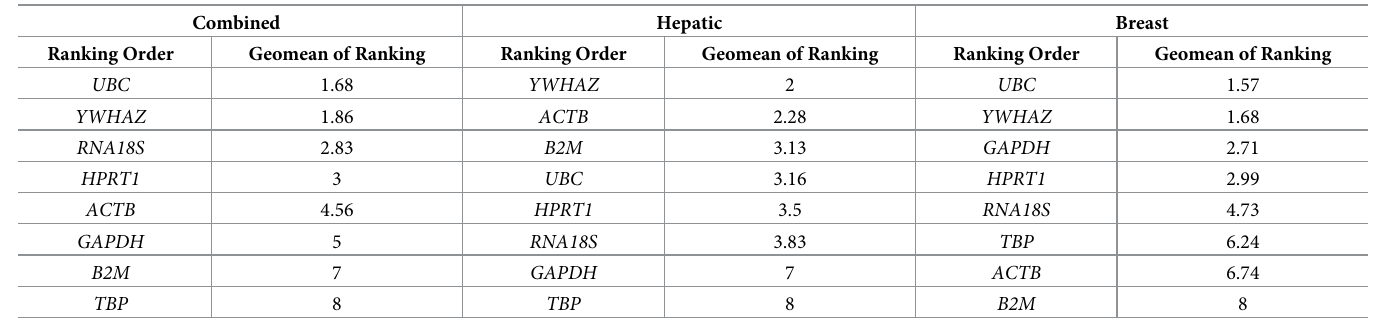
Table 6. Stability ranking order of nominee reference genes determined by RefFinder